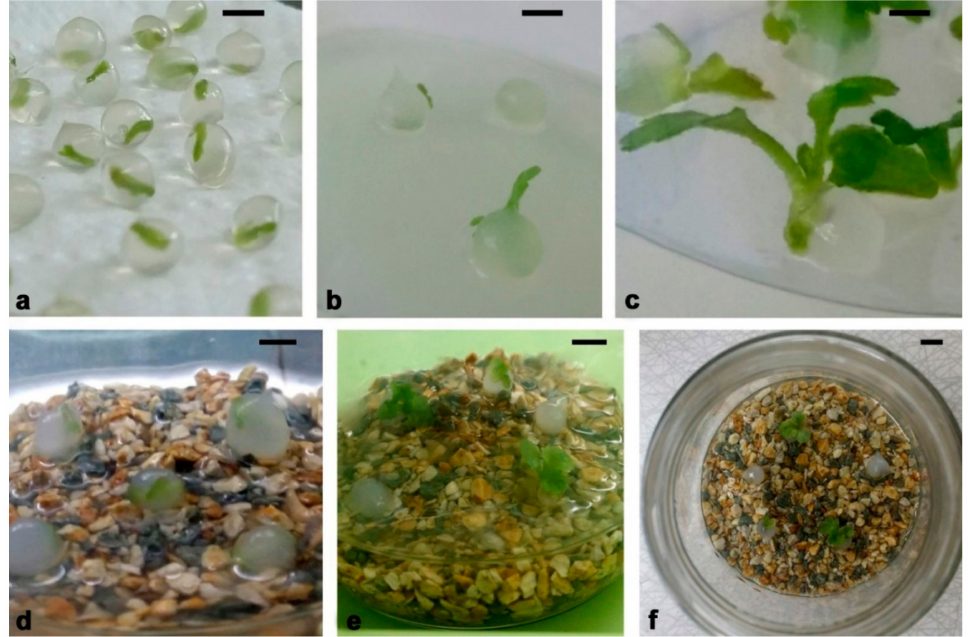
Figure 1. Chrysanthemum synseed germination under in vitro conditions. ( a ) Synseeds before plasma treatment; ( b , c ) plasma-treated synseeds grown on solid agar medium—leaf emergence after one week of culture ( b ) and shoot development after four weeks of culture ( c ); ( d , f ) plasma-treated synseeds grown on vermiculite + liquid medium—plasma-treated synseeds grown one week ( d ) and four weeks ( e , f ). Bars a–f, 5